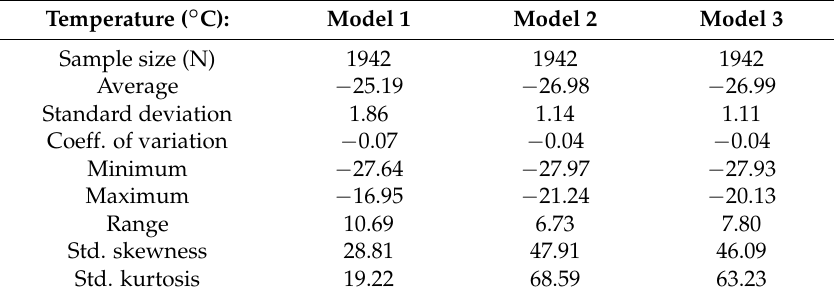
Table 4. Summary statistics of the temperature variables of the three models.